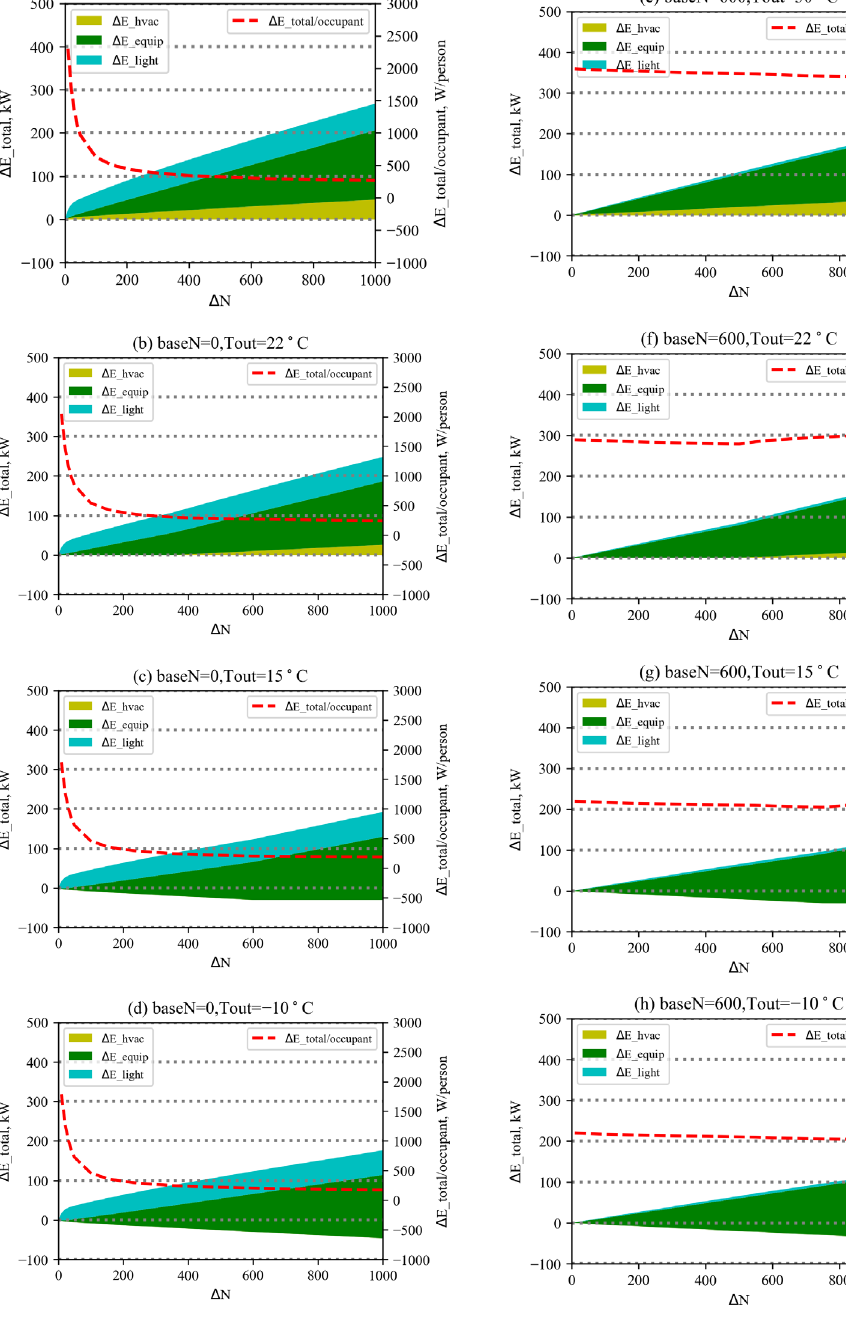
Figure 10. The influence of occupancy on the change in total energy consumption with different baseN and T out (constant fresh air